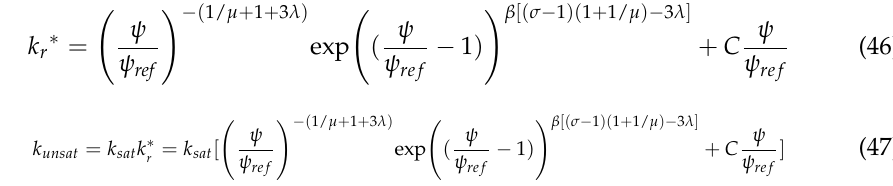
Suction(MPa) Figure 9. The prediction of unsaturated hydraulic conductivity for MX80 bentonite. 4. Summary and Conclusions This work aims to develop a new constitutive relationship for unsaturated hydraulic conductivity of compacted bentonite, including the microstructure effect. The microstruc- ture effect is represented by the change of accessible porosity (i.e., macro porosity) for water, further resulting in a varying tortuosity, specific surface area and relative hydraulic conductivity. The modified Kozeny–Carman equation was developed for saturated hy- draulic conductivity incorporating the microstructure evolution, yielding a good agree- ment with experimental results. Furthermore, a new constitutive relationship for relative hydraulic conductivity was developed, including both effects of capillary pressure and microstructural expansions during wetting path. The prediction of the new constitutive relationship is in excellent accord with the laboratory observation for GMZ and MX80 bentonite over the entire wetting path, explaining the initial decrease of hydraulic con- ductivity with declining suction (i.e., U-shaped curve) for compacted bentonite. The tra- ditional model ignores microstructure expansion, leading to an overestimation of hydrau- lic conductivity and failure in explanation of decrease of hydraulic conductivity in the